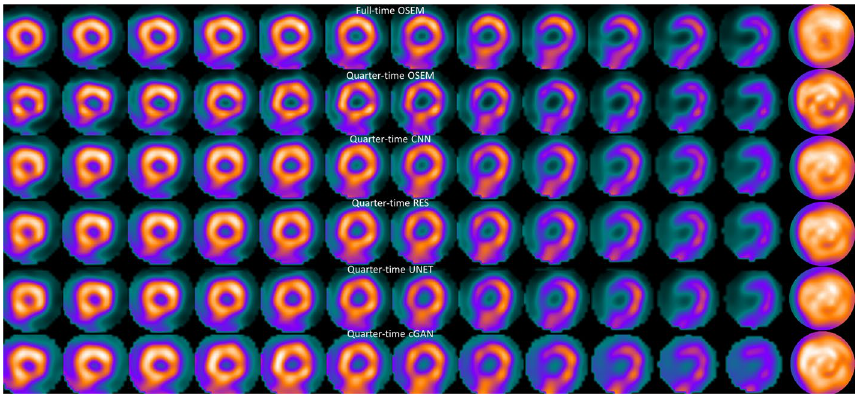
Fig. 4 Example quarter time short-axis slices and polar plot (rightmost column) of a normal stress study